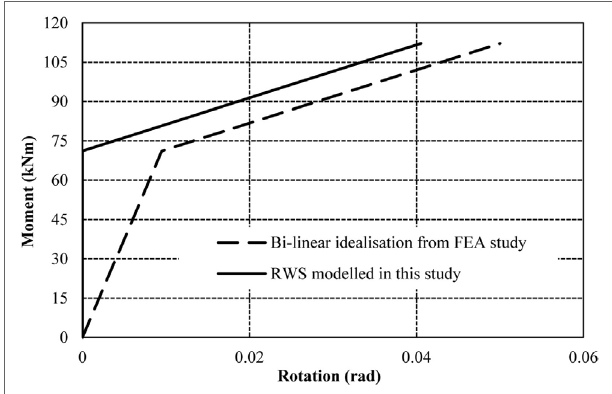
Figure 4 | Validation moment–rotation curve comparing results from Tsavdaridis and Papadopoulos (2016) and proposed reduced web section (RWS)